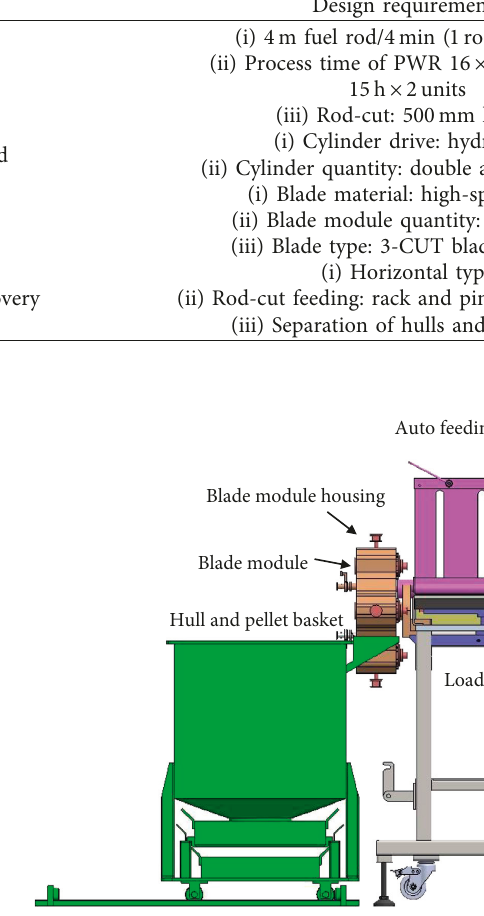
Figure 13: Main mechanism of mechanical